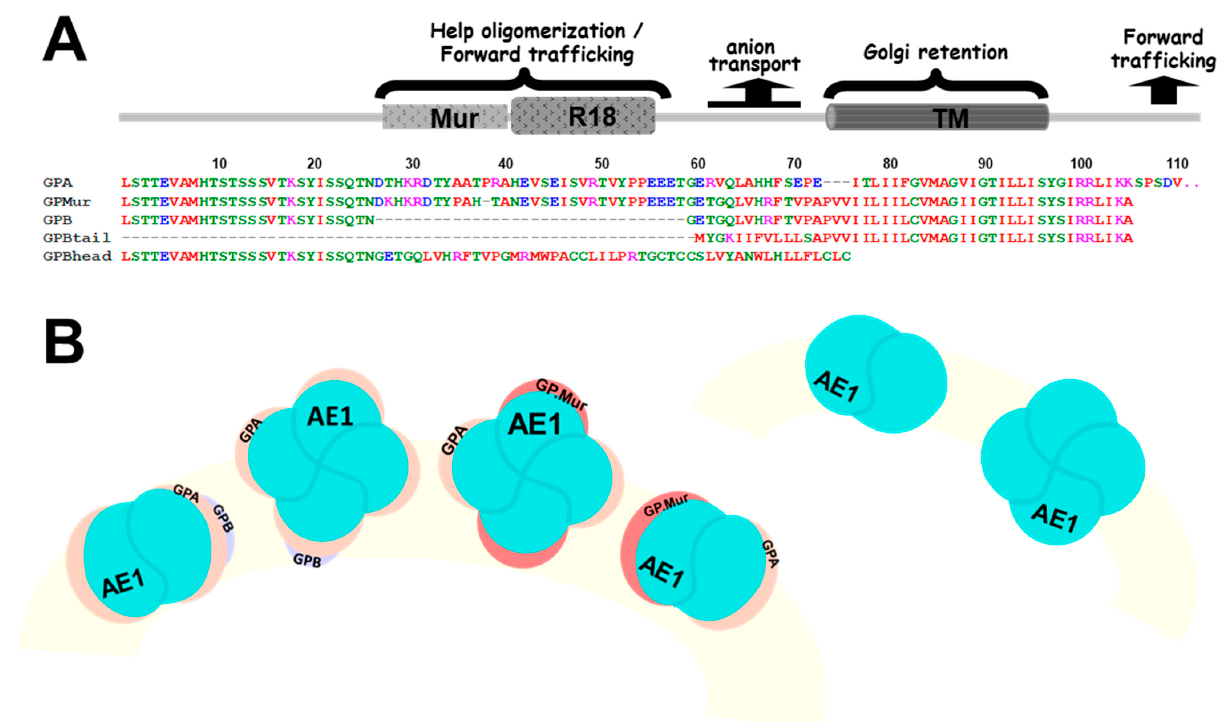
Figure 1. Structural-functional correlates for GPA/GPB and their variants. ( A ) Sequence alignments of GPA, GPB, and variants—GP.Mur, GPBtail, and GPBhead. Most C-terminal, cytoplasmic resi- dues of GPA (25 amino acids) were omitted. The cytoplasmic region of GPA has been reported